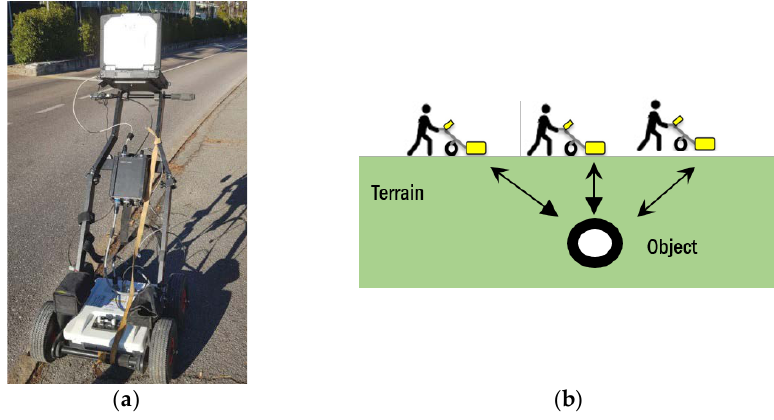
Figure 4. GPR prospecting system. ( a ) GPR components. ( b ) Sketch of survey modality.